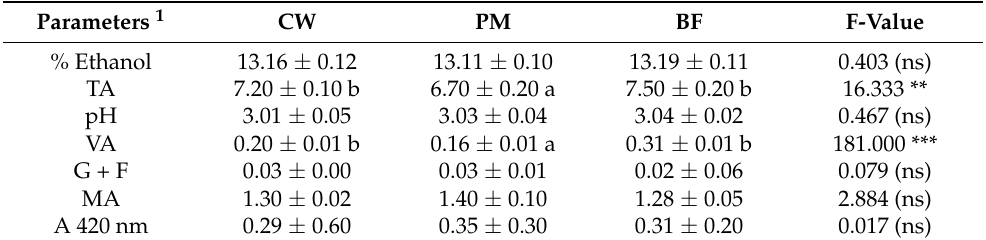
Table 1. Standard oenological parameters of Maturana Blanca wines produced by conventional winemaking (CW), conventional winemaking with pre-fermentative maceration (PM), and barrel fermentation